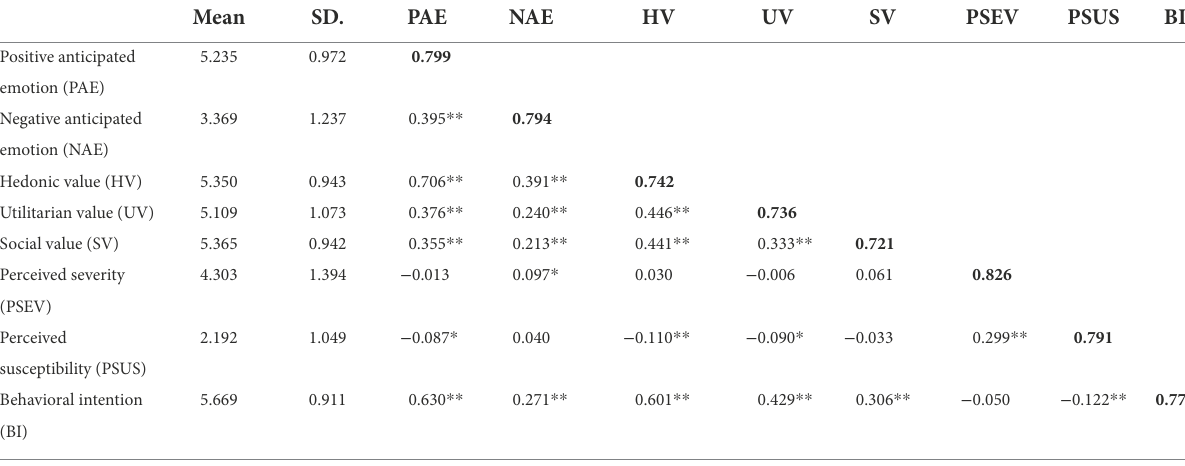
TABLE 3 Correlations and square roots of average variance extracted